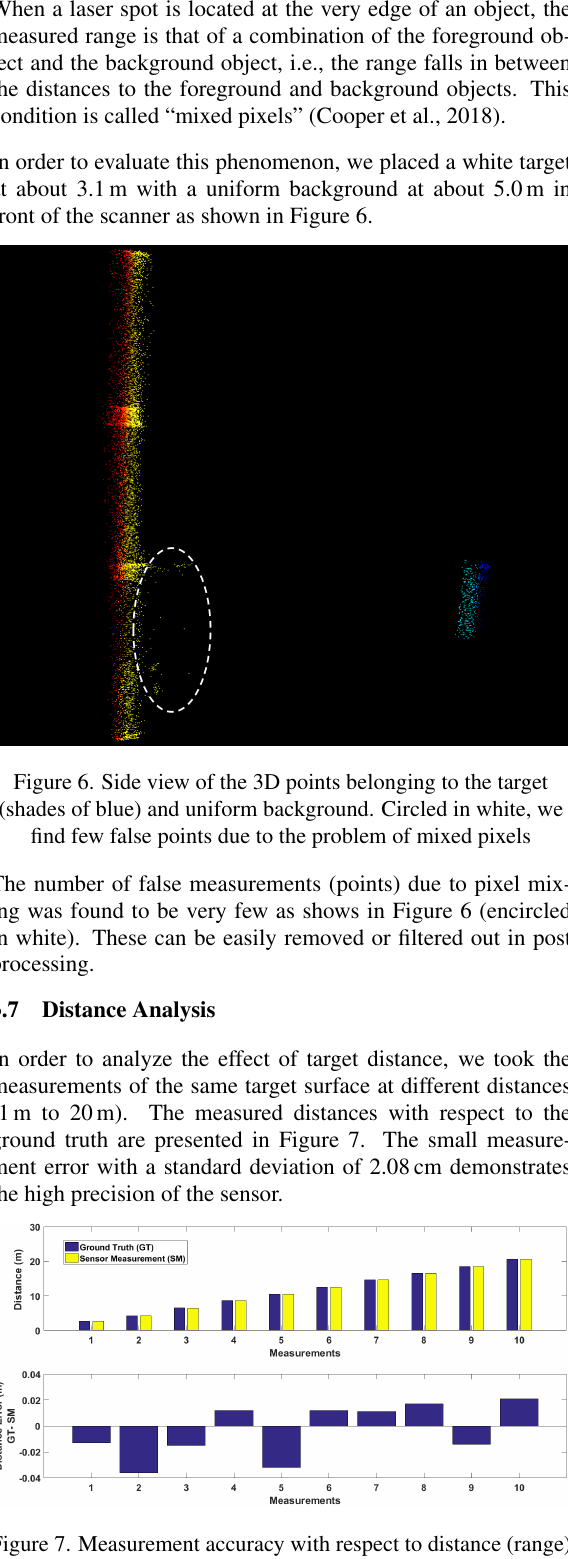
Figure 7. Measurement accuracy with respect to distance